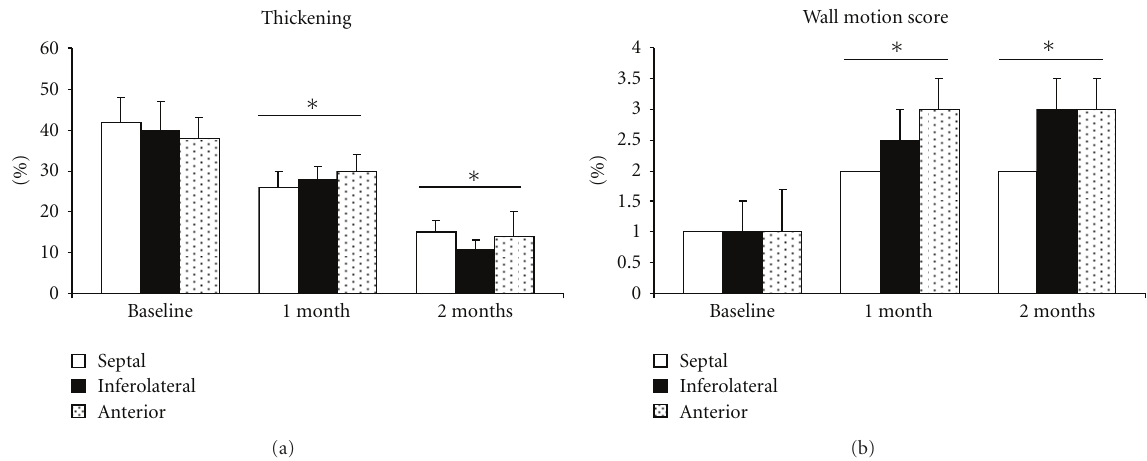
Figure 4: Over time, a substantial decrease in the thickening and the mean wall motion score of ischemic myocardial walls can be observed; ∗ P < . 01 compared to basal